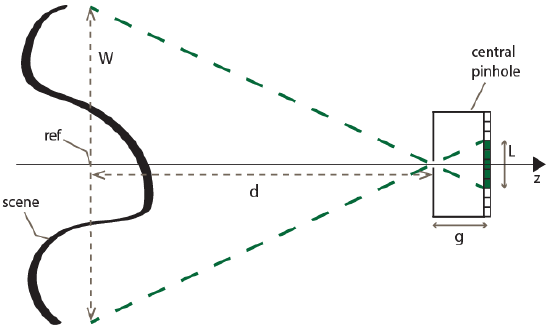
Figure 5. Setting the cropping factor. To set the number of pixels of the sub-EIs, a simple geometrical × W relation can be exploited: L = g (obviously, L has to be rounded to the nearest integer d